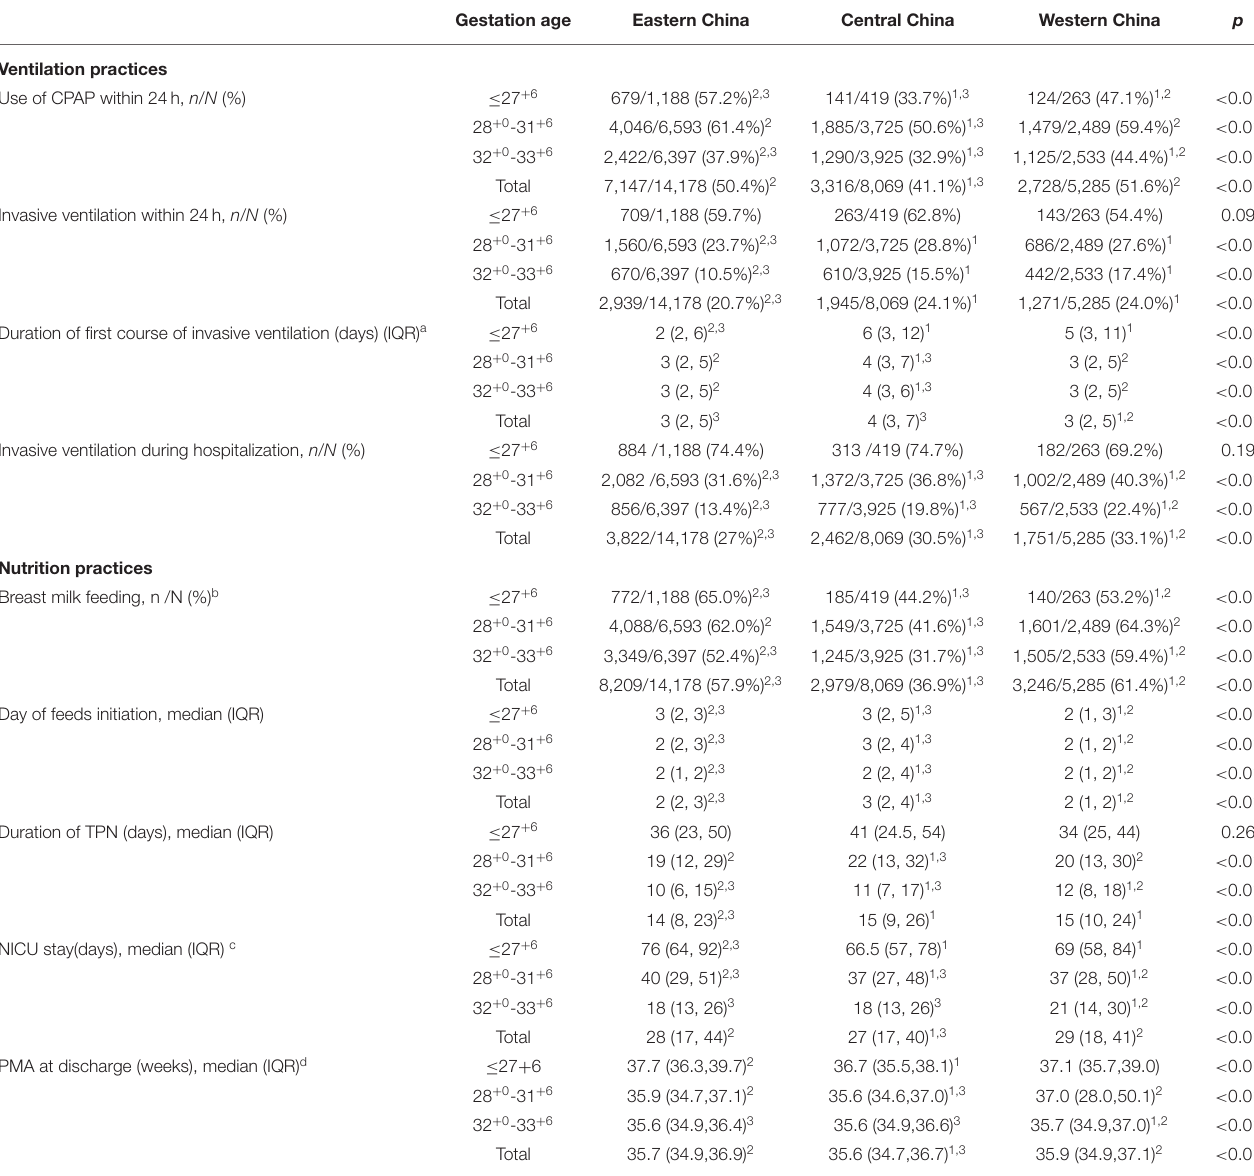
TABLE 4 | Care practices for preterm infants admitted to NICUs in different regions of China.